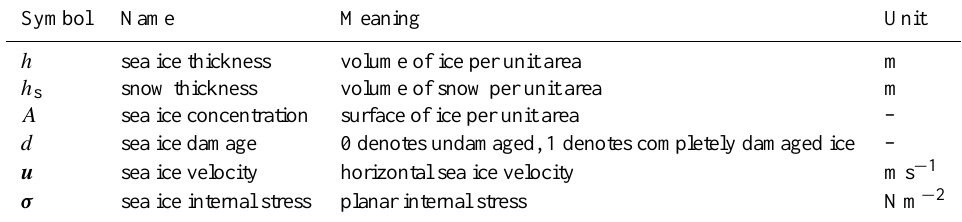
Table 1. List of variables used in neXtSIM. Symbol Name Meaning